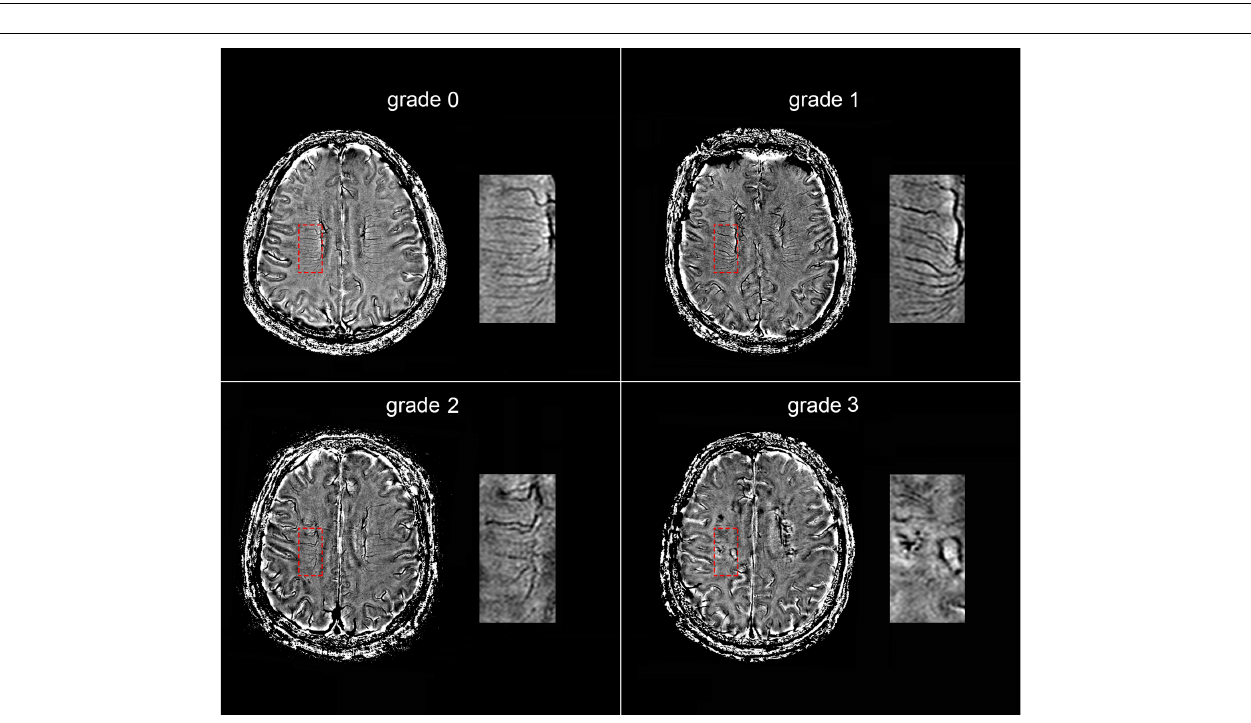
FIGURE 1 | Brain regional division. Three regions were segmented including frontal region, parietal region and occipital region according to medullary venous anatomy. The colored area were PVHs of the different brain regions.